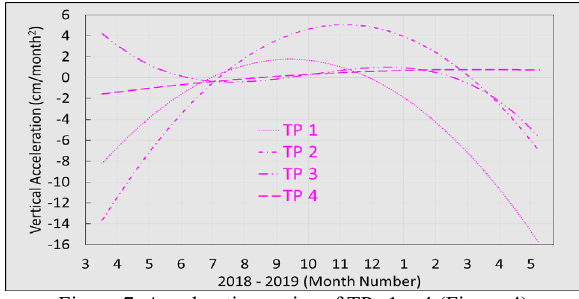
Figure 7. Acceleration series of TPs 1 – 4 (Figure